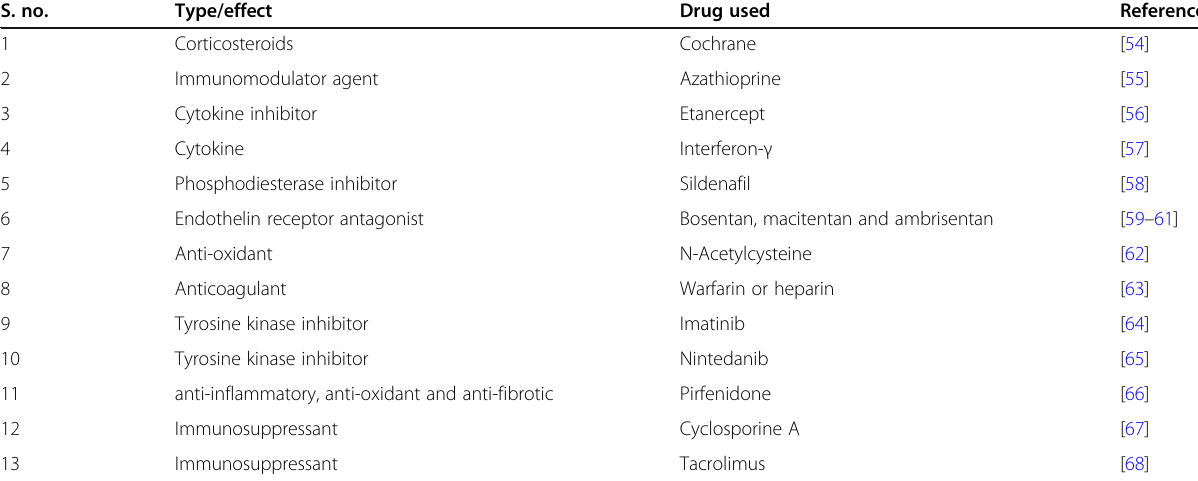
Table 2 Drug designed to treat idiopathic pulmonary fibrosis S.